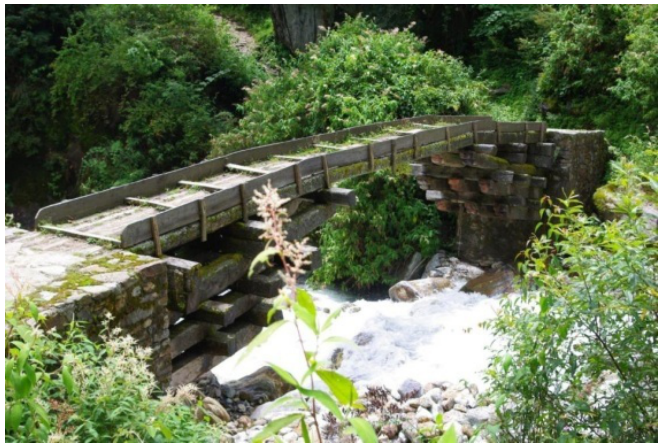
Figure 15. Traditional bridge on Laya–Gasa